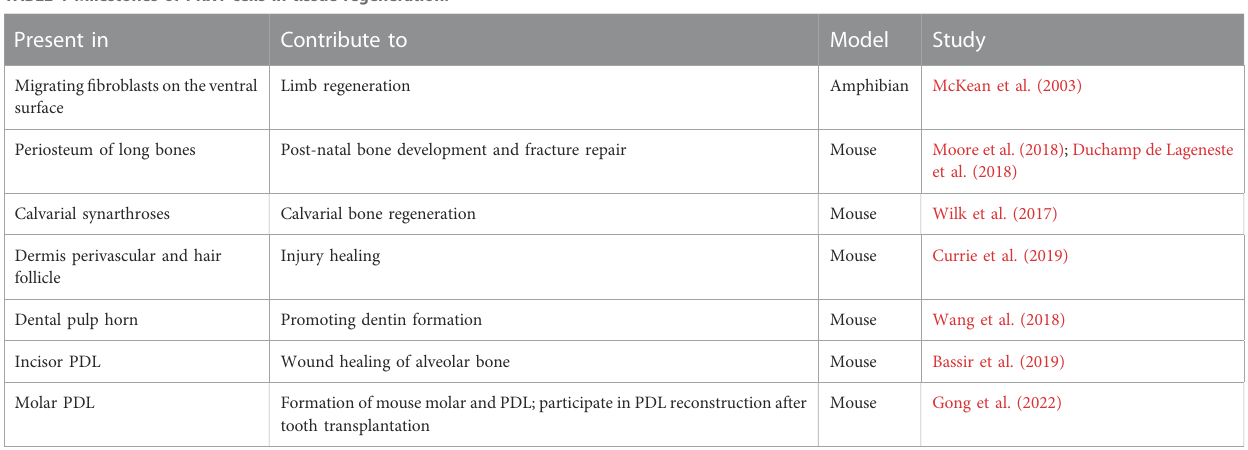
TABLE 1 Milestones of PRX1 cells in tissue